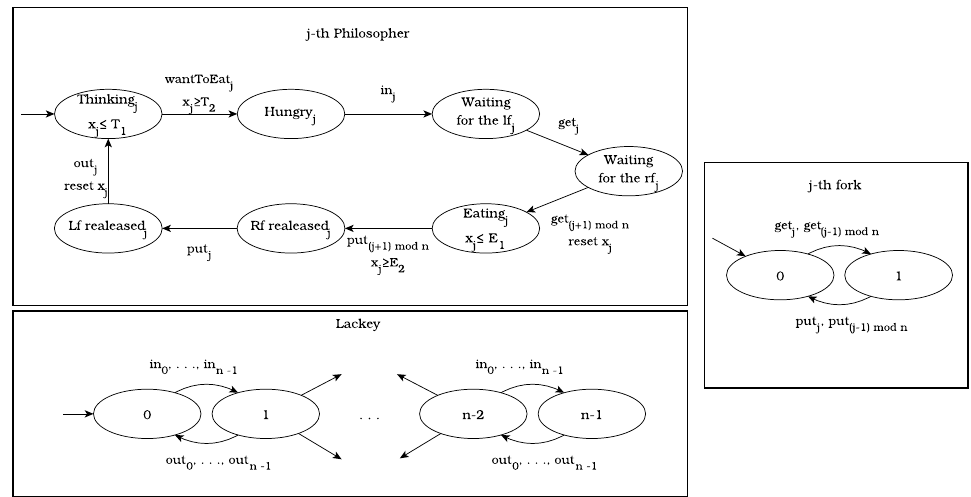
Figure 4. The TDPP